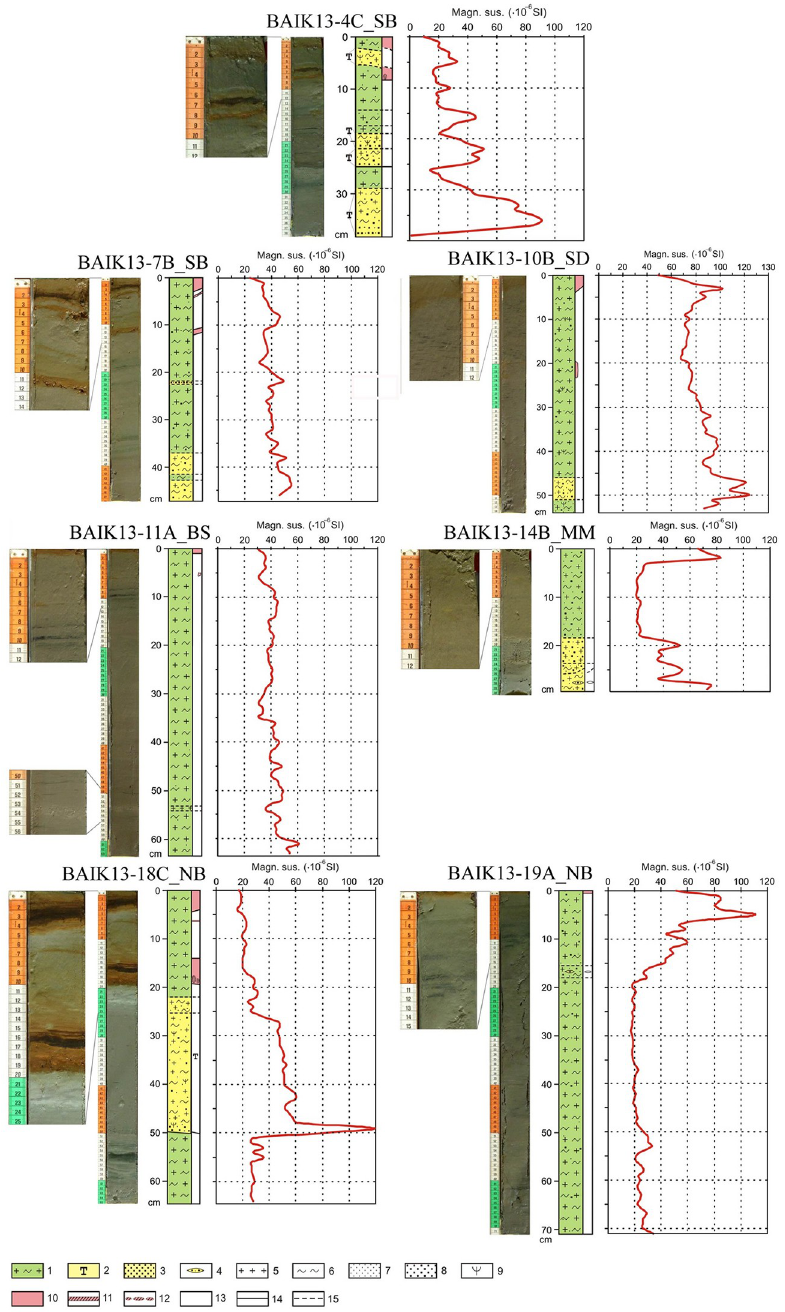
Fig 2. Core lithology and magnetic susceptibility profiles for BAIK13-4C_SB, BAIK13-7B_SB, BAIK13-10B_SD, BAIK13-11A_BS, BAIK13-14B_MM, BAIK13-18C_NB and BAIK13-19A_NB sediment cores. Lithology key: 1— pelagic mud, 2—turbidite, 3—sandy sediment, 4—diatoms, 5—clay, 6—silt, 7—sand, 8—land plant remains. Right column: 9—oxidized sediment, 10—Fe/Mn crust, 11—fragments of Fe/Mn crust, 12—O 2 reduced sediment. Boundaries between layers: 13—distinct boundaries between layers, 14—indistinct boundaries between layers. The lithology for cores BAIK13-4C_SB and BAIK13-7B_SB have previously been published in [49]. [SB: South basin, SD: Selenga Delta, BS: Buguldieka Saddle, MM: Maloe More Strait and NB: North